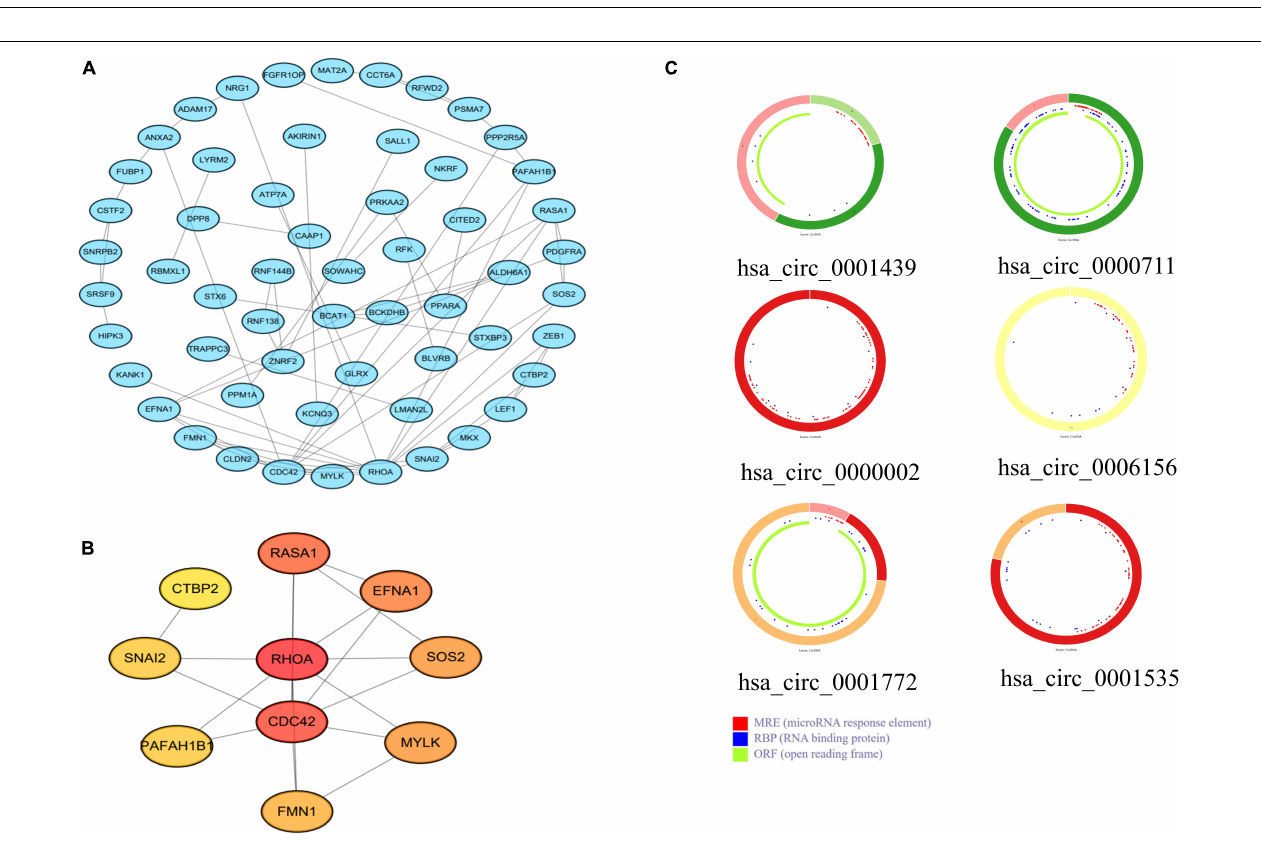
FIGURE 3 | (A) A protein–protein interaction (PPI) network was established using the 98 common differentially expressed messenger RNAs (DEmRNAs). (B) PPI network of the 10 hub genes extracted from (A) . (C) Structural patterns of the top six dysregulated circular RNAs (circRNAs) (C) .